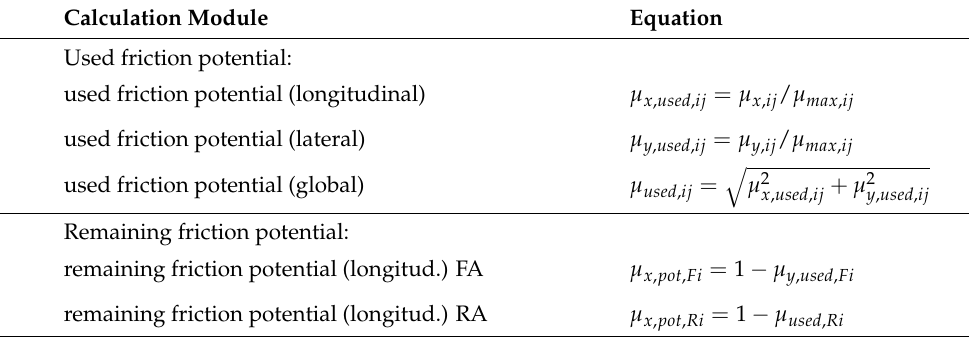
Table 2. Cont. Calculation Module Equation Used friction